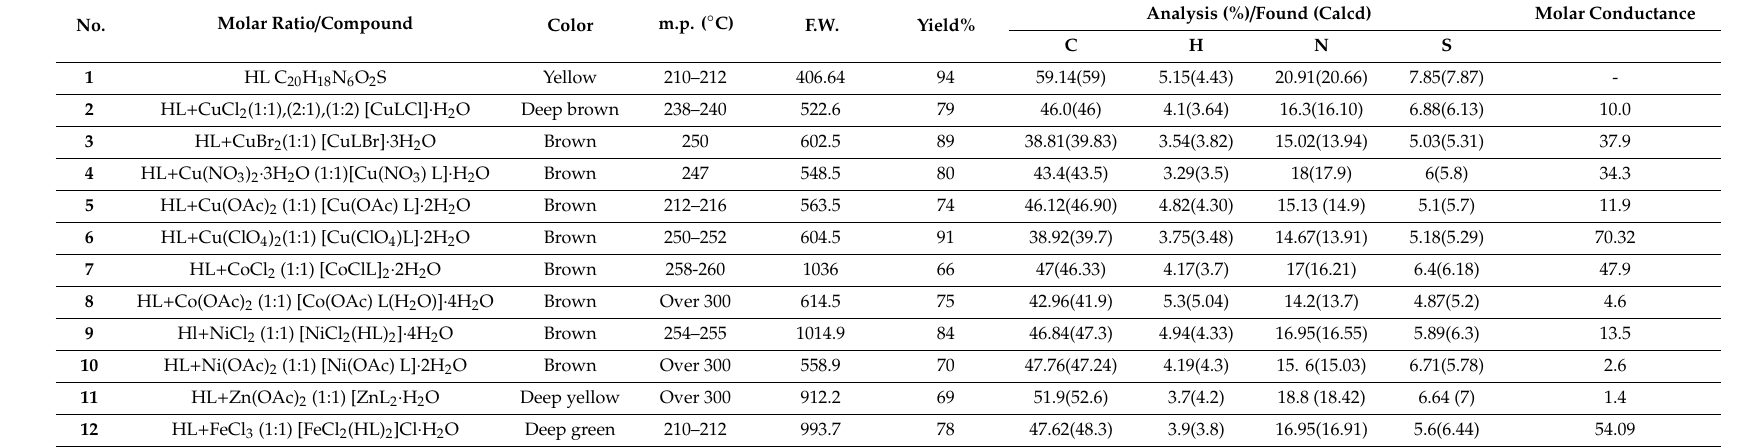
Table 1. Analytical and physical data of the ligand 1 and its metal complexes 2 – 11